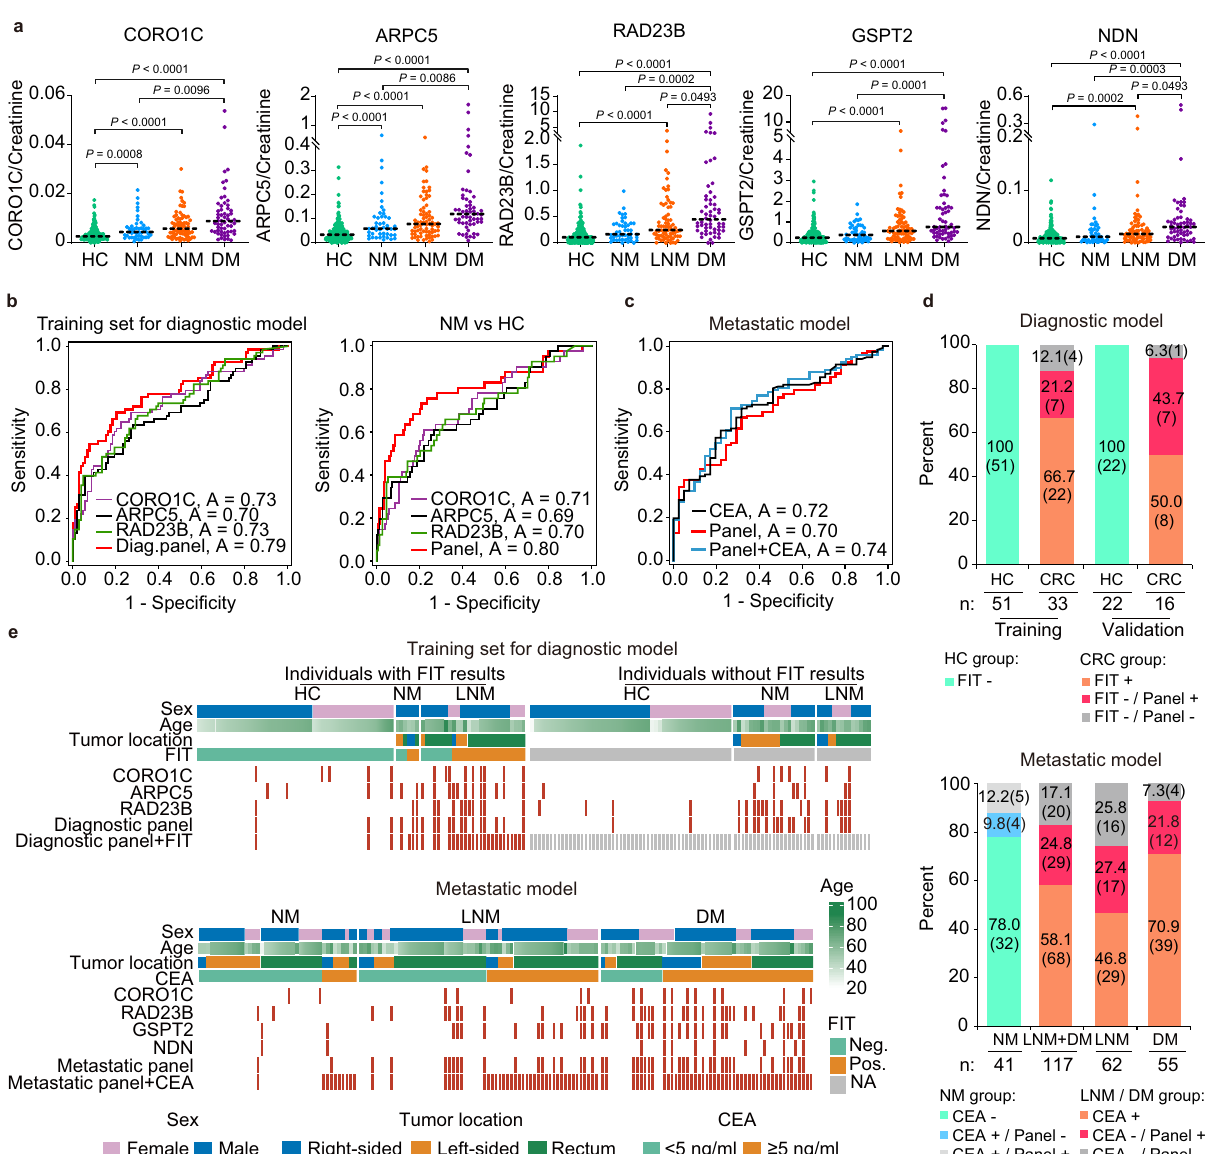
CEA + / Panel - CEA - / Panel + CEA + / Panel + CEA - / Panel - Fig. 4 Independent urine veri fi cation of the urinary protein signature using dot blot analysis. a Scatter plot for CORO1C, ARPC5, RAD23B, GSPT2, and NDN in 255 healthy controls (HCs) and 179 CRC patients, including CRC without metastases (NM; n = 46), CRC with lymph node metastasis (LNM; n = 75) and CRC with distant metastasis (DM; n = 58). The median values in each group are shown as black dotted lines. The differences between groups for each marker were analyzed by two-sided Kruskal – Wallis test followed by a Dunn ’ s multiple comparisons test. Uncropped original blots in Source Data. b ROC curve of the diagnostic panel for the diagnostic model (NM + LNM vs. HC) in the training set and discrimination of the NM group CRC from HC. c ROC curve of serum CEA, metastatic panel, and the combination of the metastatic panel and CEA for the metastatic model (LNM + DM vs. NM). d Diagnostic and metastatic predictive power of the diagnostic signature and metastatic signature in the individuals who were misdiagnosed by the FIT test or serum CEA. The values in parentheses indicate the number of samples corresponding to each percent. + , positive; − , negative; n , number of samples. e Heatmap of the dot plot data for single urinary markers as well as the diagnostic or metastatic panel with a speci fi city of 95%, and the combination of corresponding clinical biomarker indices for the diagnostic or metastatic model was considered positive when either the panel or FIT/CEA was positive. Red: positive using the cutoff value with a speci fi city of 95%. The FIT test, serum CEA, tumor location, sex, and age are indicated by color-coding. CRC colorectal cancer, FIT fecal immunochemical test, CEA carcinoembryonic antigen, Neg . negative; Pos . positive; NA not available. The source data are provided in Source RAD23B) for CRC diagnosis and a panel of four urinary bio- activation of RAC1 induces membrane ruf fl ing and lamellipodia markers (CORO1C, RAD23B, GSPT5, and NDN) for CRC formation at the leading edge 24,25 . ARPC5 is one of the subunits of the Arp2/3 complex, which is the central actin nucleator that metastatic risk strati fi cation were de fi ned. Among these proteins, promotes branched fi lament formation and creates a complex CORO1C and ARPC5 are known regulators of actin cytoskeleton cortical membrane actin network to generate the force necessary dynamics. CORO1C is necessary for the release of inactive RAC1 for protrusion 26 . RAD23B is involved in the nucleotide excision from the nonprotrusive membrane and the activation and repair of damaged DNA, and its abnormal expression has been redistribution of RAC1 to a protrusive tip; accordingly, the